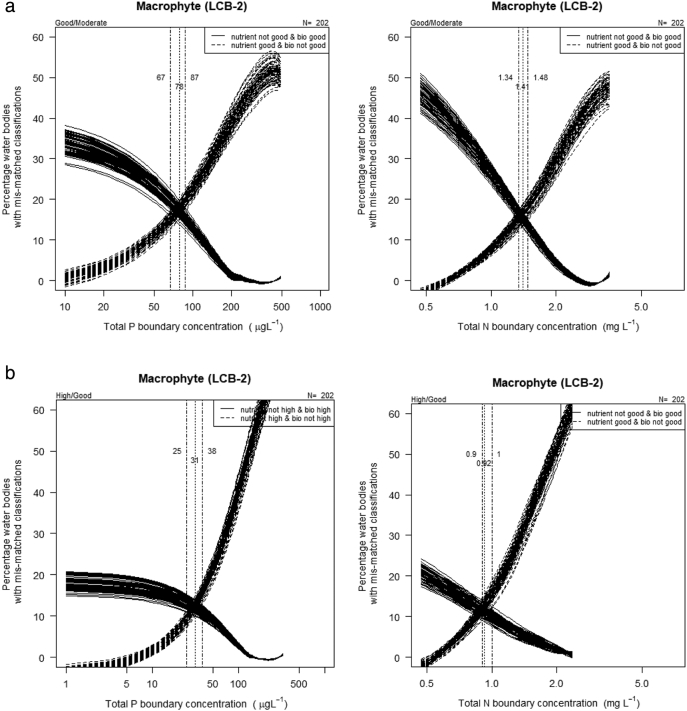
Percentage of water bodies where macrophyte or nutrient classifications for ecological status differ in comparison to the level used to set the boundary values for good/moderate or worse (top row) and high/good or worse (bottom row) for a) total phosphorus and b) total nitrogen in high alkalinity very shallow (L-CB2) lakes. Lines are loess smooths, vertical lines mark mean and range of intersections which identify the good/moderate boundary.